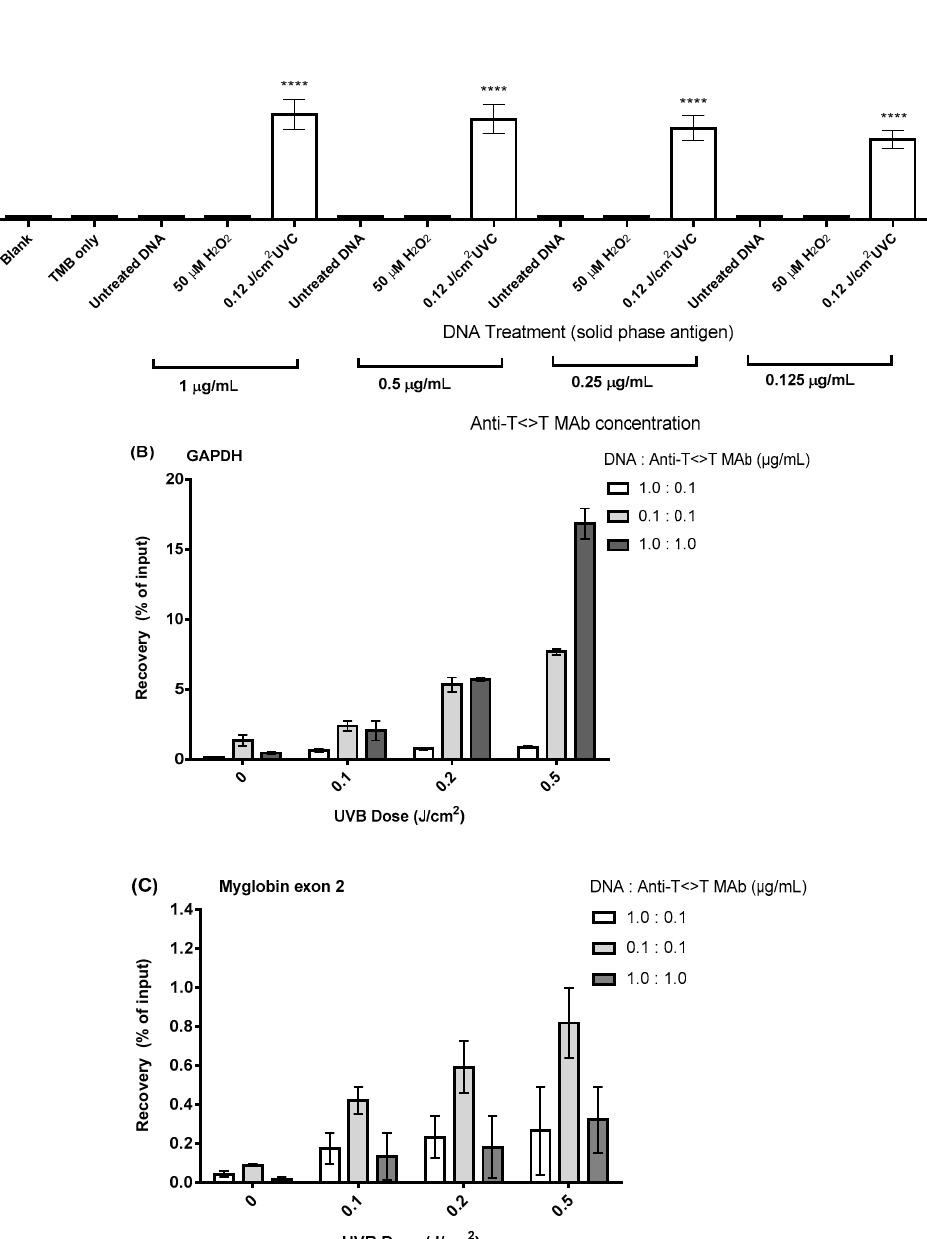
Figure 2. Specificity of the anti-T<>T Mab, and its optimisation, determined by DDIP-qPCR. DNA immunoprecipitation was performed using the MeDIP kit from Diagenode, with commercially available, extracted, human DNA irradiated with 0, 0.1, 0.2 and 0.5 J/cm 2 UVB, and a monoclonal antibody against thymine dimers (T<>T). ( A ) ELISA results demonstrating the specificity of the anti-T<>T Mab for UV-modified DNA. Quantitative PCR was performed using primers specific for ( B ) the GAPDH gene promoter, an actively expressed gene, and ( C ) the Myoglobin exon 2, an inactive gene. Recovery was expressed as a percentage of the amount of immunoprecipitated DNA compared to the input DNA after qPCR. The results are presented as the mean ± SEM of three independent experiments. **** represents p < 0.001.